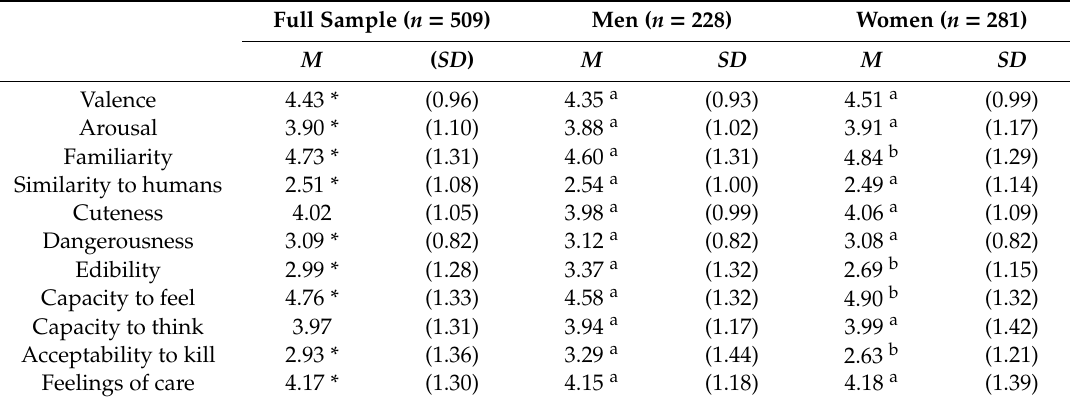
Table 3. Mean evaluations across dimensions: The full sample and by